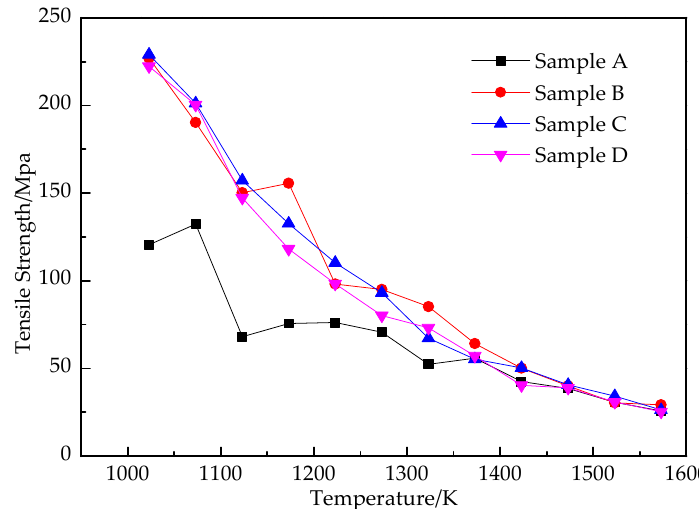
Figure 4. Tensile strength curve of Q355GJ steel with different Nb contents.